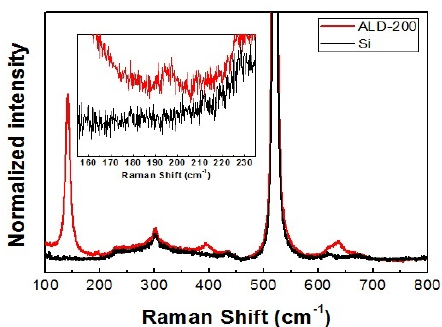
Figure 3. Raman spectra of 66-nm-thick TiO 2 film and a Si wafer. The inset shows a zoom-in around the wavenumber of 200 cm − 1 .